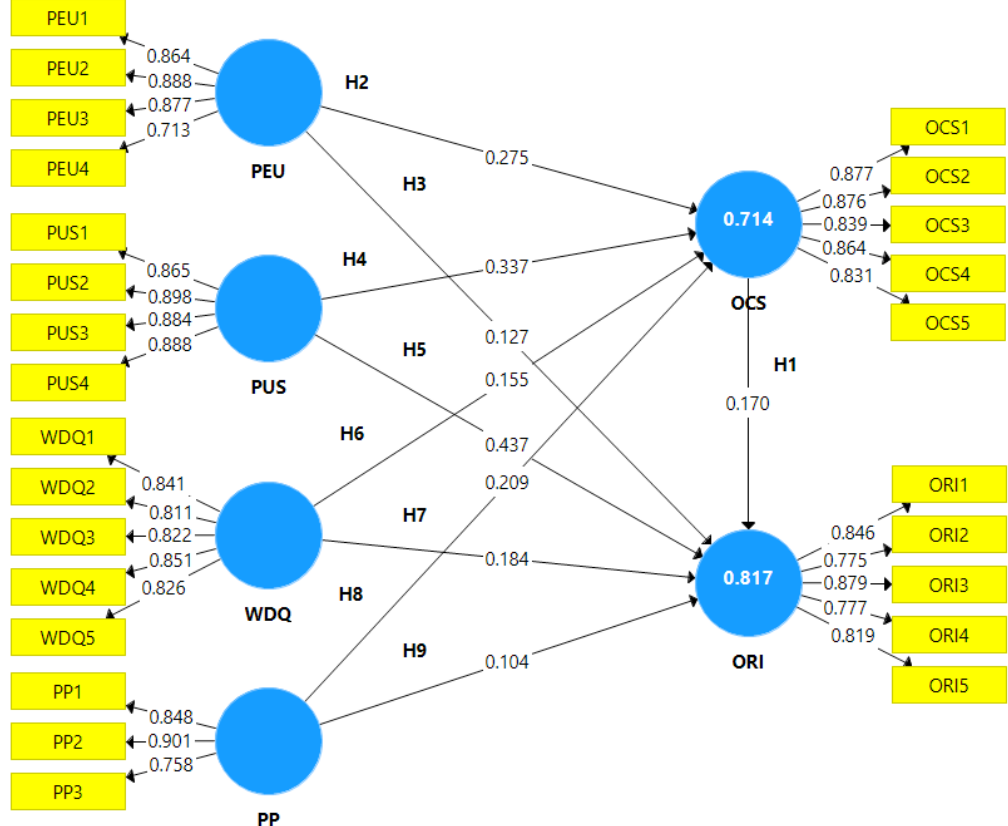
Figure 2. PLS-SEM results